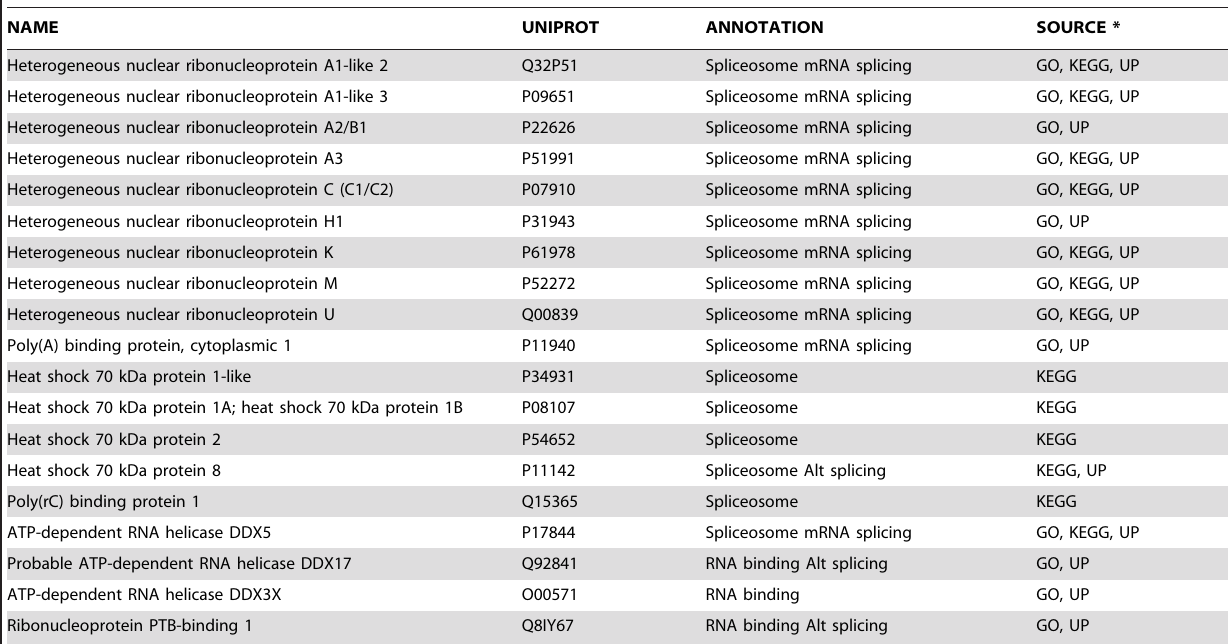
Table 1. TBX3 interacting proteins involved in mRNA